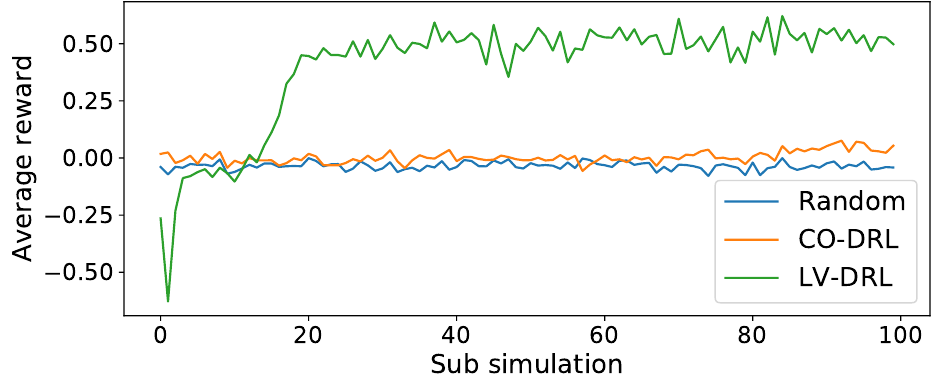
Figure 3. Average rewards of each sub simulation in training. Blue, orange and green lines represents average rewards of random, capital only-deep reinforcement learning (CO-DRL), and liquidation-value deep reinforcement learning (LV-DRL) models.